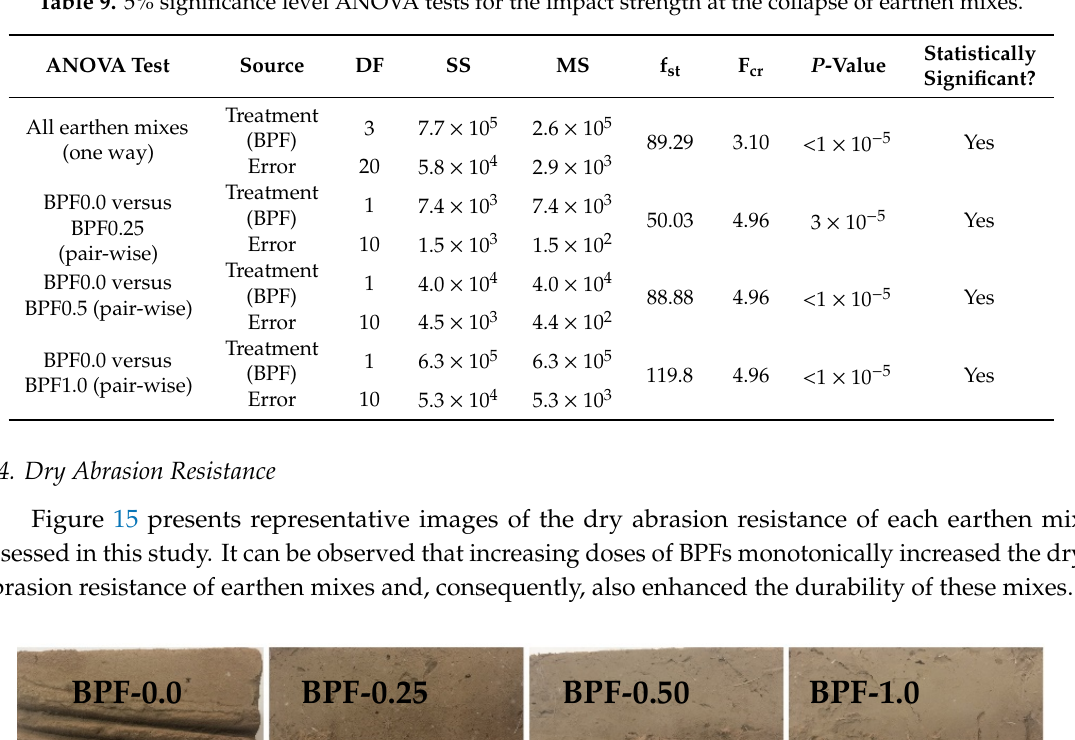
Figure 16. Dry abrasion coefficient results of each earthen mix. The ANOVA test results of C a are presented in Table 10, which shows a statistically significant improved average dry abrasion resistance behavior of earthen mixes BPF-0.5 and BPF-1.0 compared to BPF-0.0. However, earthen mix BPF-0.25 did not demonstrate a statistically significant improved average performance compared to BPF-0.0, as further explained by the large p -value of 0.23 for the pair-wise test between earthen mixes BPF-0.0 and BPF-0.25. It is possible that the smaller BPF dose used in BPF-0.25 (compared to earthen mixes BPF-0.50 and BPF-1.0) did not provide enough fibers to bond with the damaged clayey matrix and maintain the integrity of the material. 0 123456789